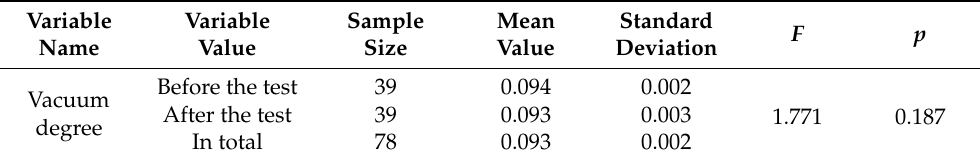
Table 5. Variance analysis results of vacuum degree before and after 12,000 liposuction and drain fatigue